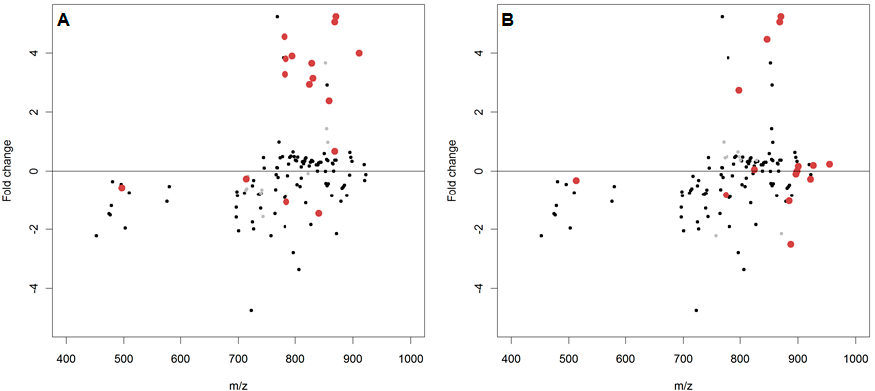
Figure 4. The log 2 (fold changes) of putatively annotated polar lipids and the potentially oxidised products thereof from D. magna lipid extracts. Red dots denote a spectral peak separated from the putatively annotated peak by either ( A ) a single oxygen ( m / z 15.99491) or ( B ) a double oxygen ( m / z 31.98983). Isomeric overlap between an annotated species and oxidised product is denoted by a light grey dot.